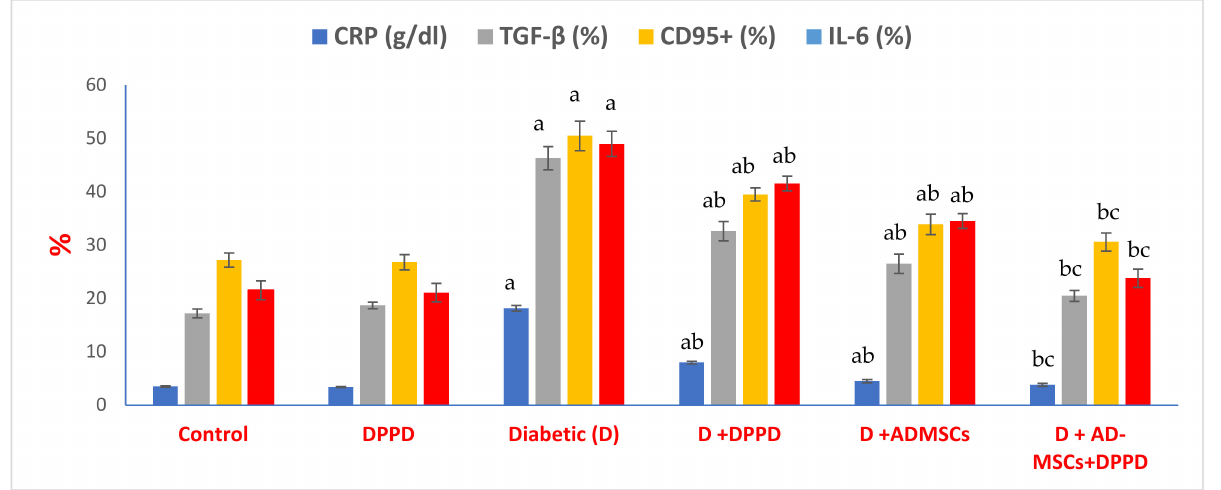
Figure 5. Serum CRP & pancreatic TGF- β , CD95, and IL-6 levels. Values expressed as ± SEM ( n = 6). a, b & c are Significant differences ( p ≤ 0.05) compared to control, diabetic untreated and DPPD-diabetic treated groups, respectively. % is the percent of change compared to the diabetic group.